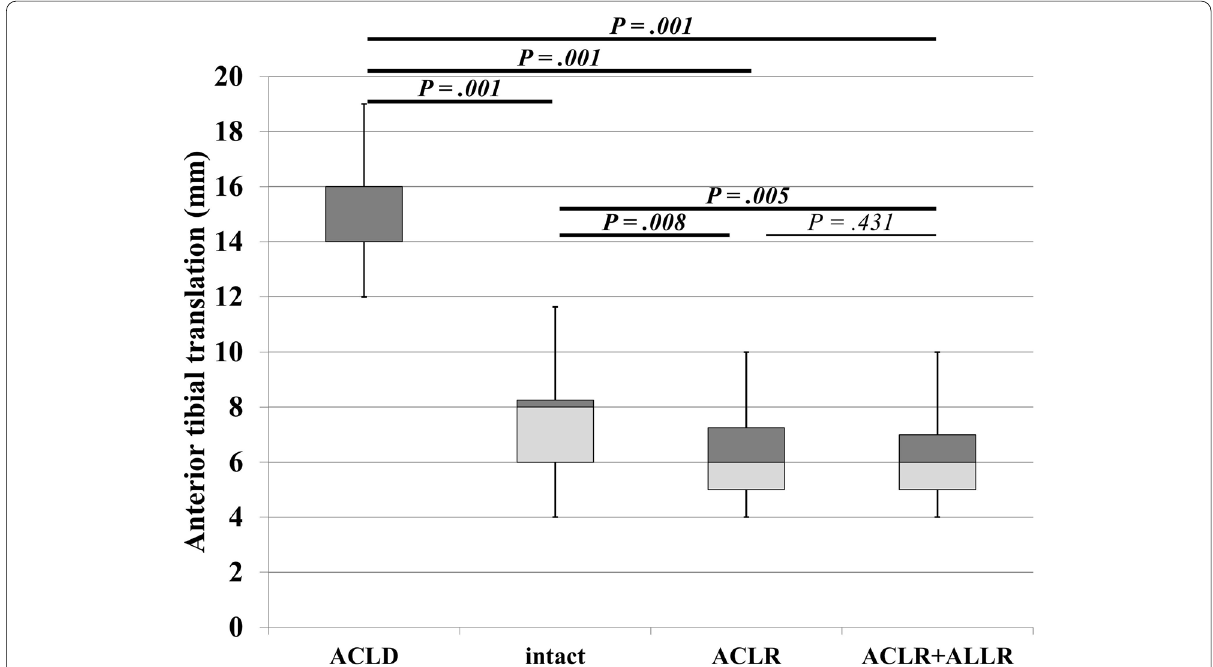
Fig. 2 Instability in the Lachman test. Box plot of anterior tibial translation in the Lachman test. P -values in bold indicate statistically significant correlations ( P < .05). ACLD, before operation for ACL-injured knee; intact, before operation for uninjured contralateral knee; ACLR, after temporary fixation of the isolated ACL grafts; ACLR ALLR, after temporary fixation of both ACL and ALL grafts +